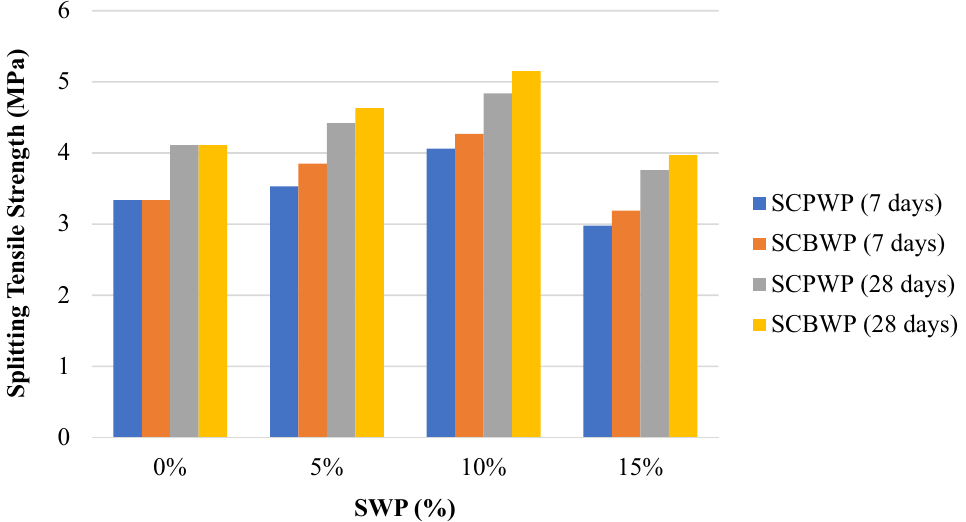
Fig. 12 Splitting tensile strengths (7 and 28